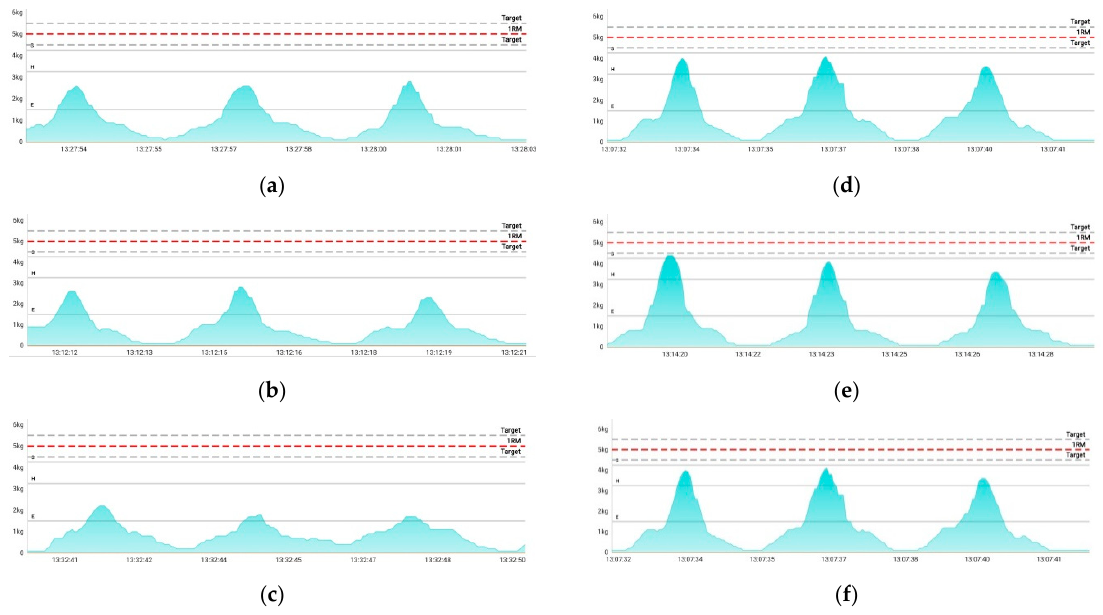
Figure 11. Images of collected sEMG signals by different types of embroidery-based textile electrodes with wearable devices. ( a ) Cf; ( b ) C3; ( c ) C1; ( d ) Wf; ( e ) W3; ( f ) W1.